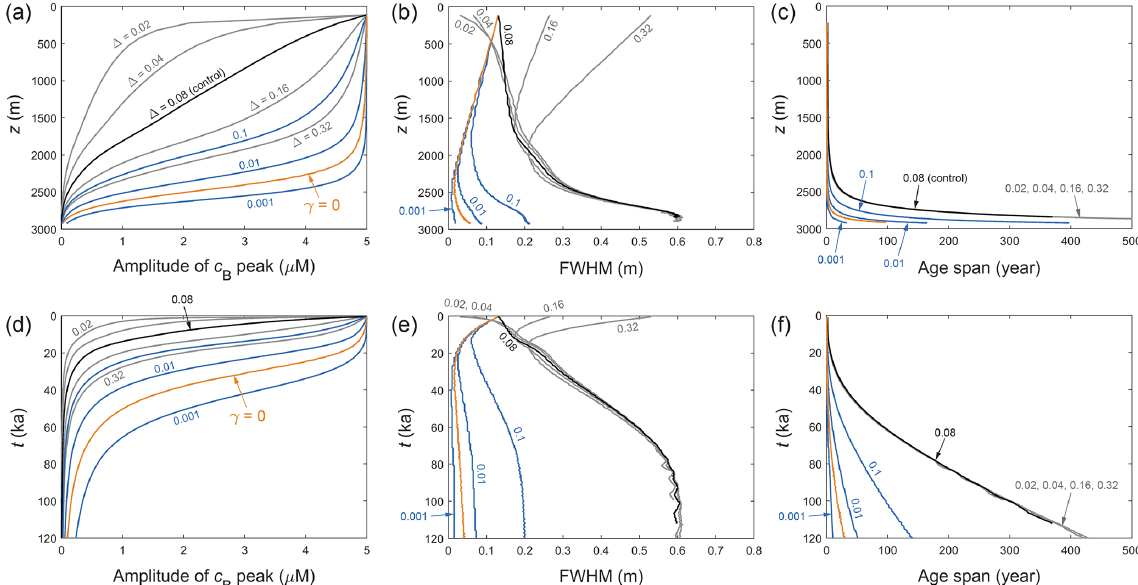
Figure 7. Changing morphometry of the signal peak – its amplitude, full width at half maximum (FWHM), and age span – in the GRIP ice core for different model parameters, plotted against depth (a–c) and age of the ice (d–f) . Black curves plot the control run of Fig. 5a, and orange curves plot the γ = 0 run of Fig. 5d. Grey curves plot the results of altering the width parameter (cid:49) of the doped peak from 0.08 (control) to four other values. Blue curves plot the outcomes of suppressing molecular diffusivity D in the control run by the multiplicative factors 0.1, 0.01, and 0.001 to simulate vein blockage. Parameter labels use the same colours as the curves. Peak width becomes difficult to measure as amplitude diminishes, explaining the jittery appearance of some curves at depth.